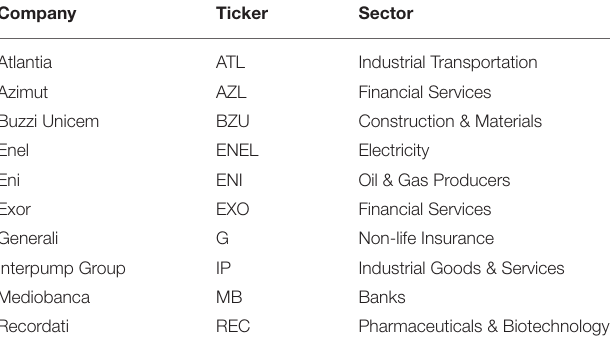
TABLE 1 | The 10 selected